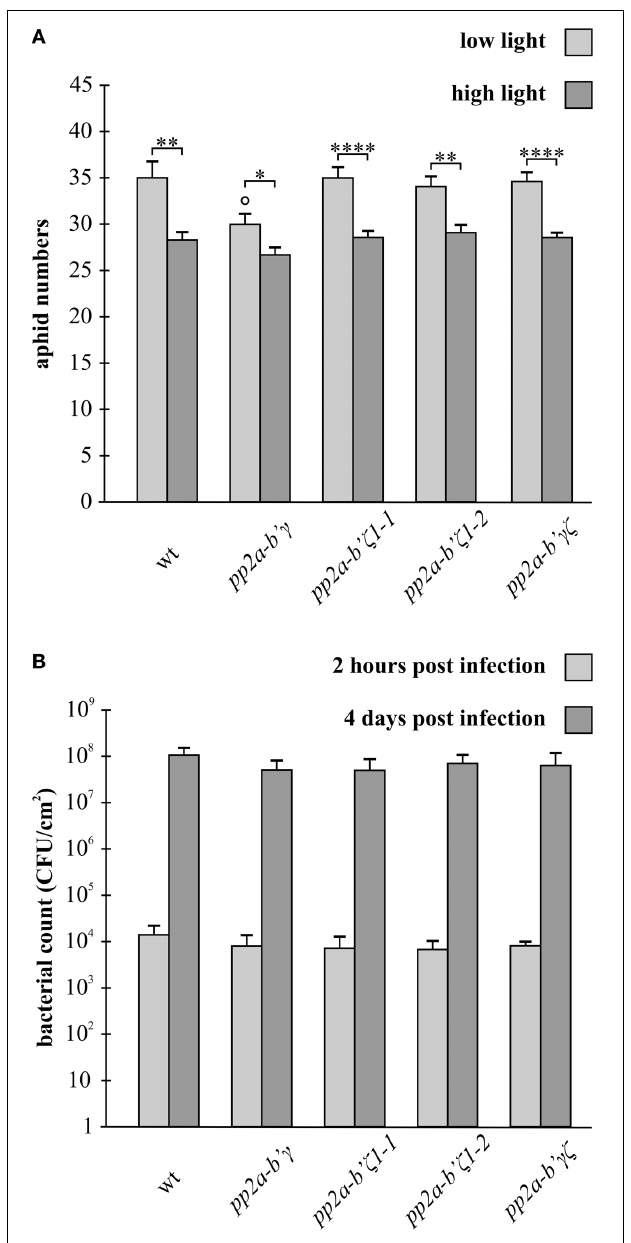
FIGURE 6 | A comparison of aphid fecundity in the pp2a-b ’ γ , pp2a-b ’ ζ 1-1, pp2a-b’ ζ 1-2, and the pp2a -b ’ γζ double mutant plants grown under either low light or following a 7-day pre-treatment with high light (A), and the effects of these genotypes on infection by the hemibiotrophic pathogen Pseudomonas syringae (B). In (A) , the numbers of aphids present per plant were measured 2 weeks after the onset of infestation in plants that had either been grown for 5 weeks under low light (250 μ mol m − 2 s − 1 ) or on plants that had been grown for 2 weeks under low light followed by 7 days under high light (800 μ molm − 2 s − 1 ) and then returned to the low light growth conditions prior to infestation and then grown with aphid infestation for a subsequent period of 2 weeks. The results are average values ± standard error values, n = 14. ∗ p < 0 . 05; ∗∗ p < 0 . 01; ∗∗∗∗ p < 0 . 0001 in Student’s t -test and One-Way ANOVA comparisons between LL or HL light conditions. ◦ p < 0 .